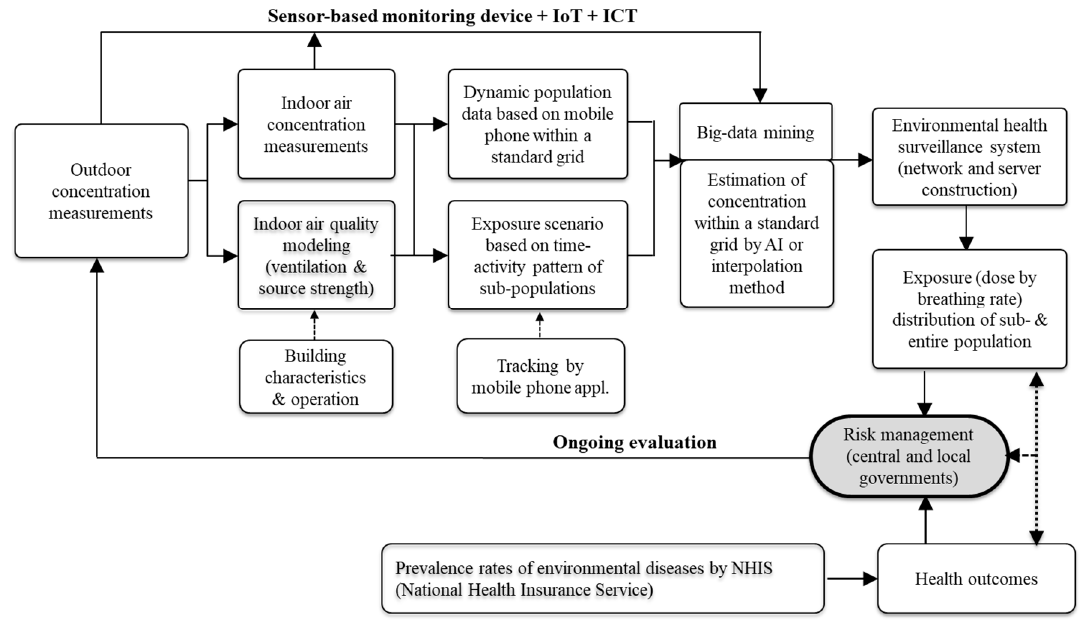
Figure 2. Overview of the development of an environmental health surveillance system for a population through the advancement of air pollution exposure assessment.